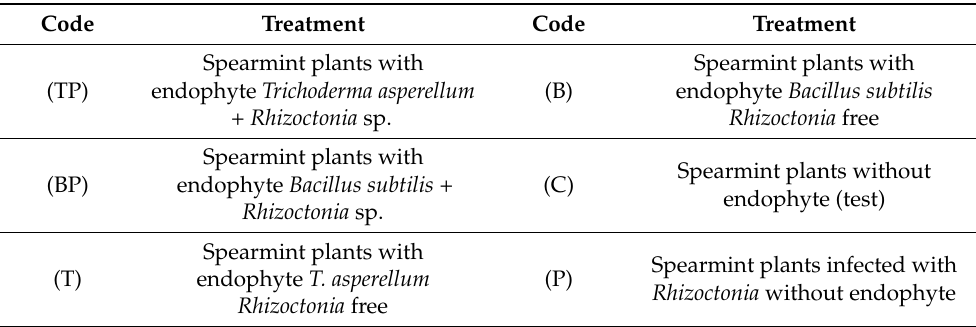
Table 3. Treatments used for the evaluation of the effect of Mentha spicata plants with endophytes of B. subtilis and T. asperellum and the pathogen Rhizoctonia sp., on the incidence of the disease, dry mass (aerial part and roots), and specialized